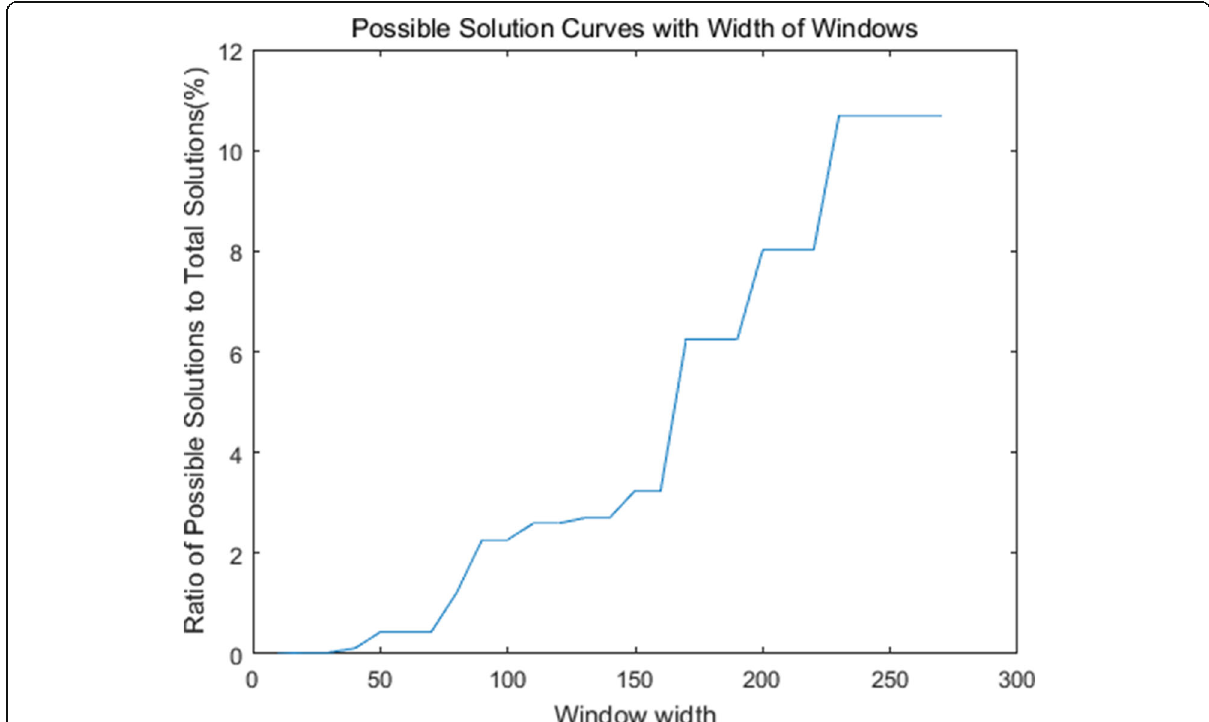
Fig. 17 Possible solution curves with different width of windows. Number of possible solutions under different window